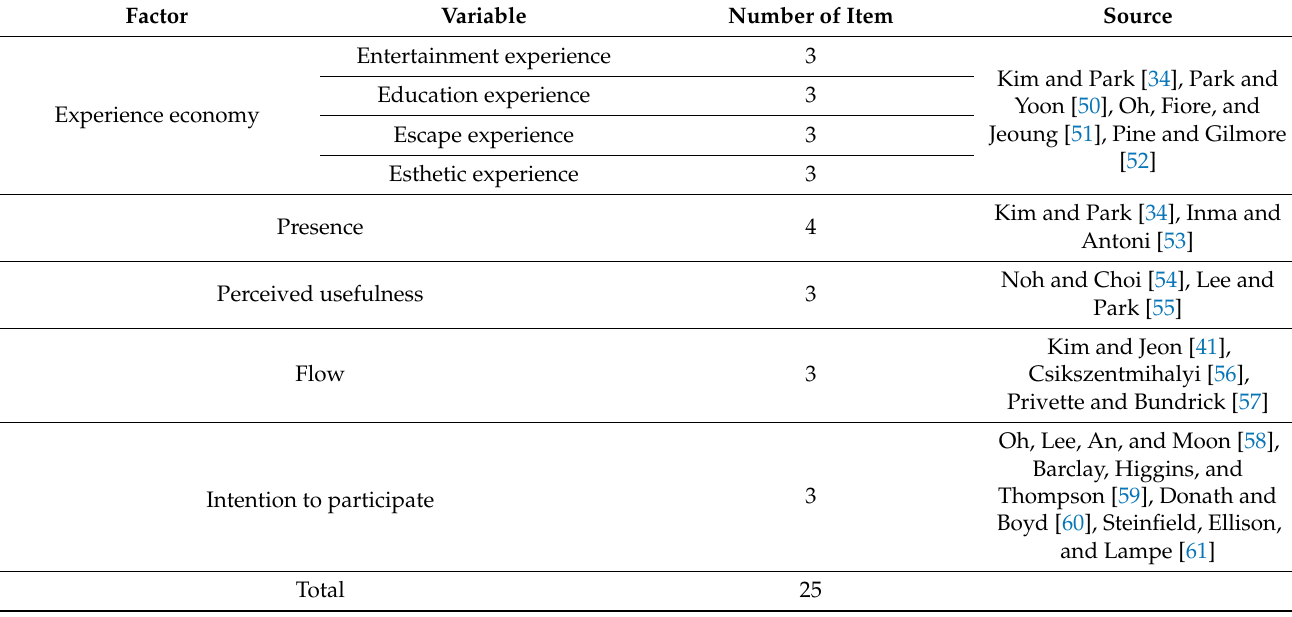
Table 3. Formation and source of the measurement